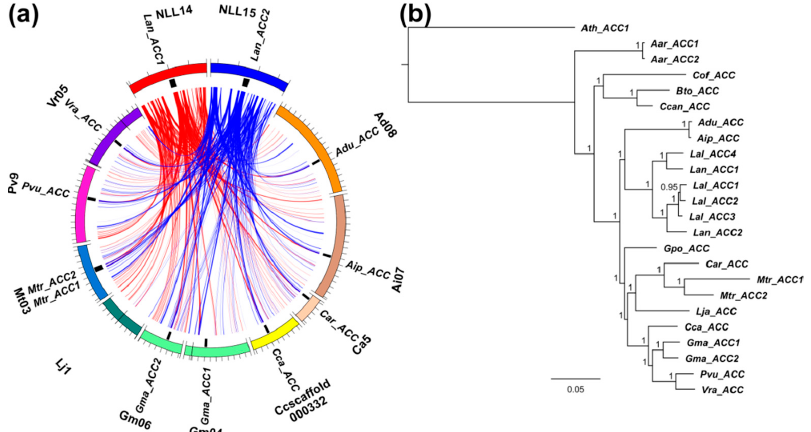
Figure 5. Comparative mapping and phylogenetic inference of legume cytosolic ACCase genes. ( a )